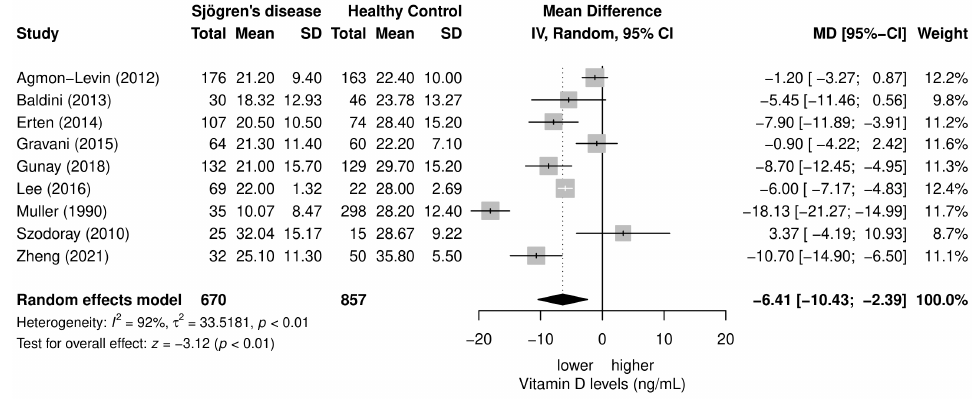
Figure 3. Meta-analysis of vitamin D levels in patients with SD in comparison to controls [18–26]. Due to the large heterogeneity between studies, a subgroup meta-analysis was per- formed based on the geographical location of the included studies to evaluate the poten- tial source of the observed heterogeneity. Five studies conducted their research on the European population, two studies on the Turkish population, and two studies on the East Asian population. The results of the geographical subgroup meta-analysis are shown in Figure 4. Overall, only subgroups of the Turkish and East Asian populations showed a significant overall effect of lower vitamin D levels in patients with SD in comparison to healthy controls (MD = − 8.33; 95% CI − 11.06, − 5.59; p < 0.01 and MD = − 7.90; 95% CI − 12.42, − 3.38; p < 0.01; respectively), and interestingly, only a subgroup of studies performed on the Turkish population showed no heterogeneity. Studies on the European population showed substantial heterogeneity ( I 2 = 96%, p < 0.01) and did not show a significant overall effect ( p = 0.21). Figure 4. Subgroups meta-analysis based on geographical location of included studies evaluating the vitamin D levels in SD patients in comparison to controls [18–26].